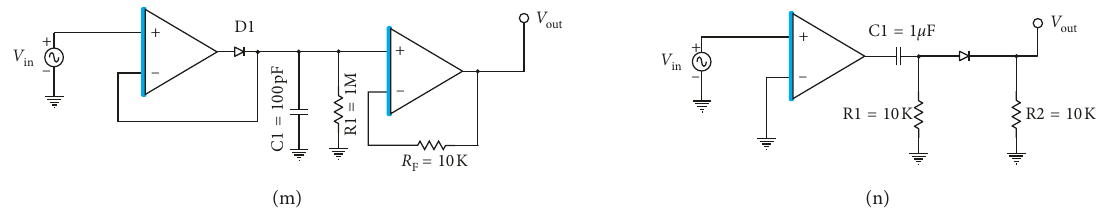
Figure 5: Analog signal processing applications. (a) Noninverting amplifier. (b) Inverting amplifier. (c) Summer. (d) Subtractor. (e) Differentiator. (f) Integrator. (g) Half-wave rectifier. (h) Full-wave rectifier. (i) Clipper. (j) Clamper. (k) Noninverting comparator. (l) Inverting comparator. (m) Peak detector. (n) Zero crossing